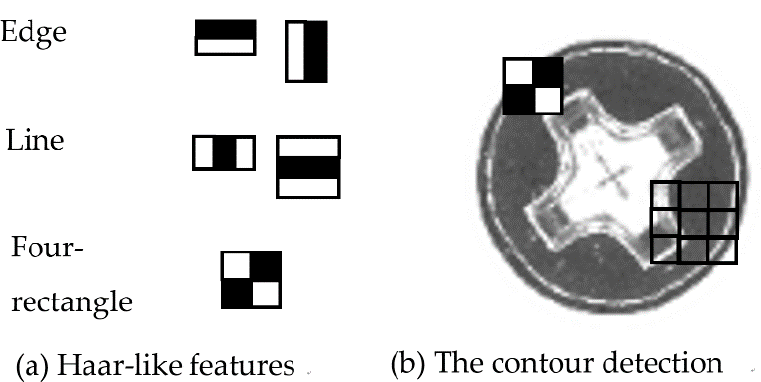
Figure 3. Haar-like features applied on the contour detection of the screw’s cap head.